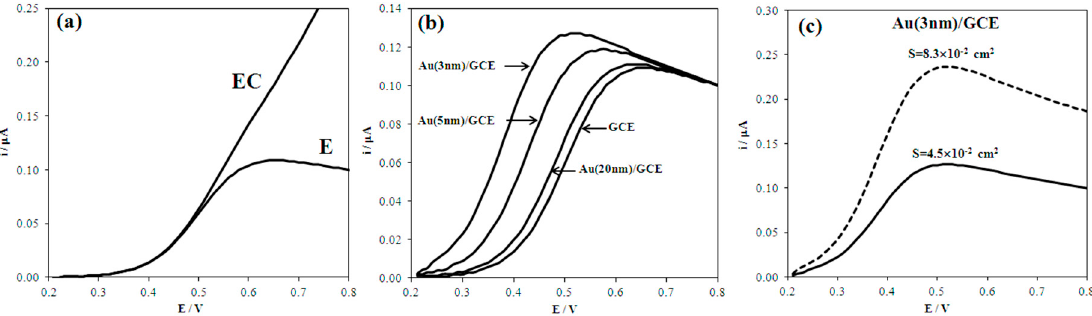
Figure 1. Calculated anodic voltammograms of 0.02 mM UA for different electrode processes: ( a ) electrochemical (E) and electrochemical, including catalytic stage (EC) at GCE; ( b ) electrochemical process at GCE, Au(20 nm)/GCE, Au(5nm)/GCE, Au(3nm)/GCE with equal surface area S = 4.5 × 10 − 2 cm 2 ; and ( с ) electrochemical process at Au(3nm)/GCE with different nanoparticle surface.